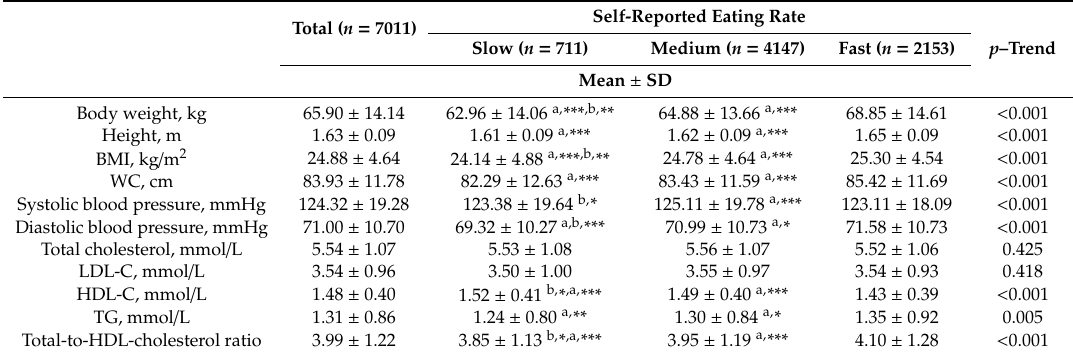
Table 2. Body composition, blood glucose, and lipid profiles, of participants according to tertile groups of self-reported eating rate in the Singapore Multi-Ethnic Cohort 2, n = 7011 1